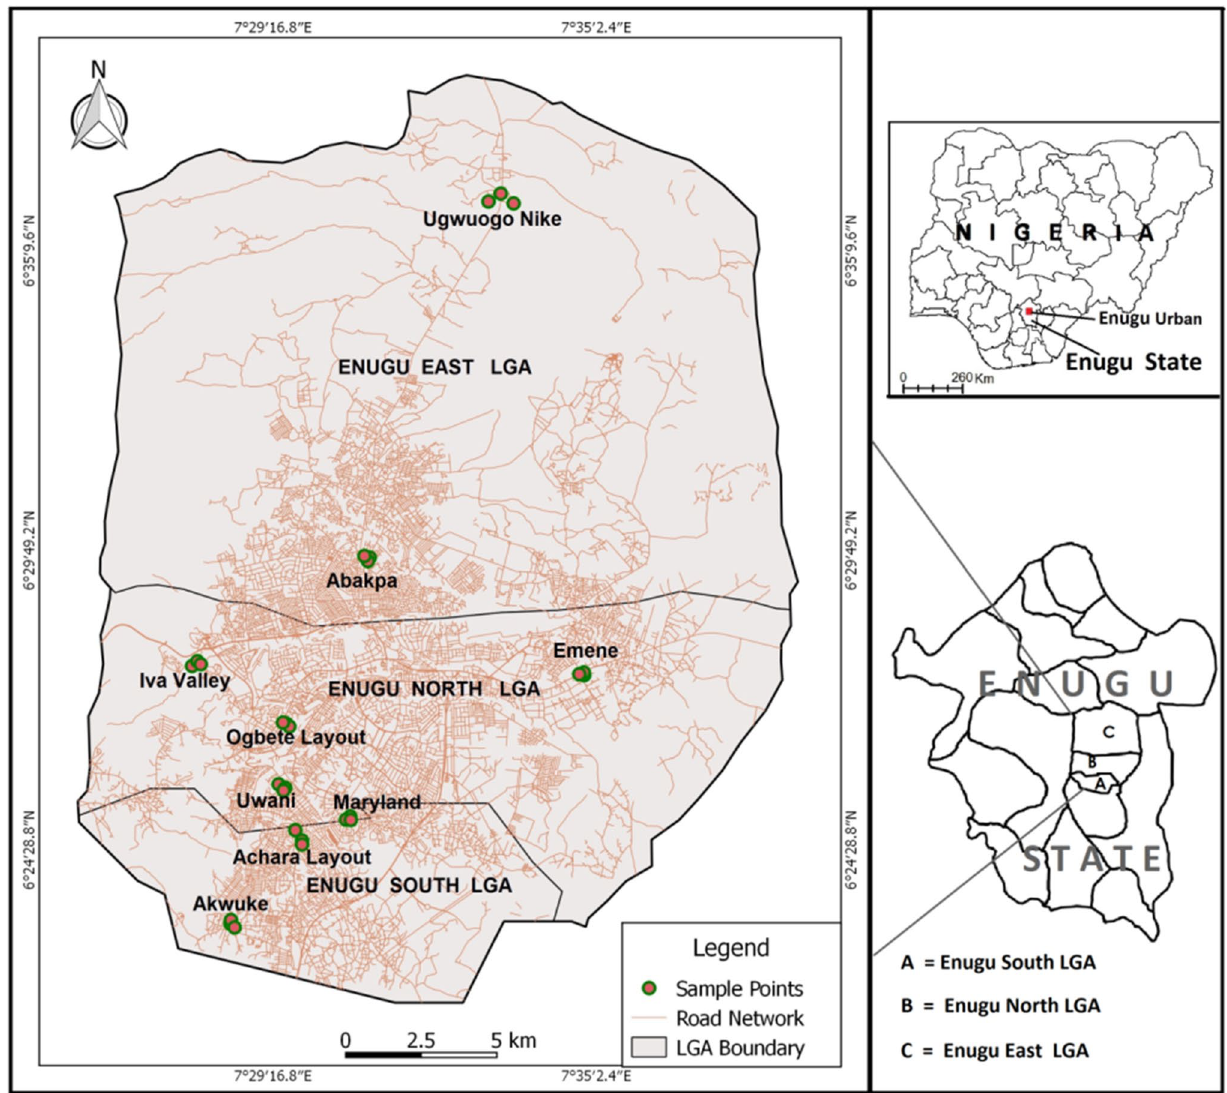
Fig. 1 Enugu city showing sampling locations of the